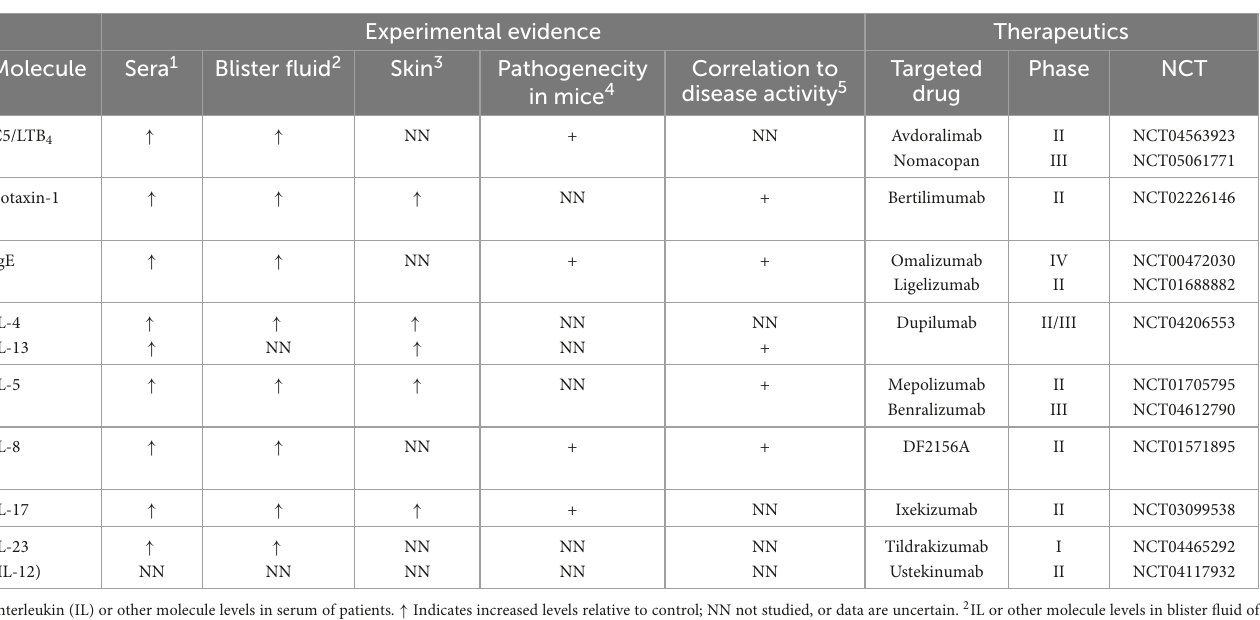
TABLE 1 Overview of immunological players involved in the pathogenesis of bullous pemphigoid according to findings from serological, blister fluid, skin samples, and mice models analysis as well as their current clinical relevance based on ongoing and terminated clinical trials (published or registered at www.clinicaltrials.gov, accessed on 15 December 2022).